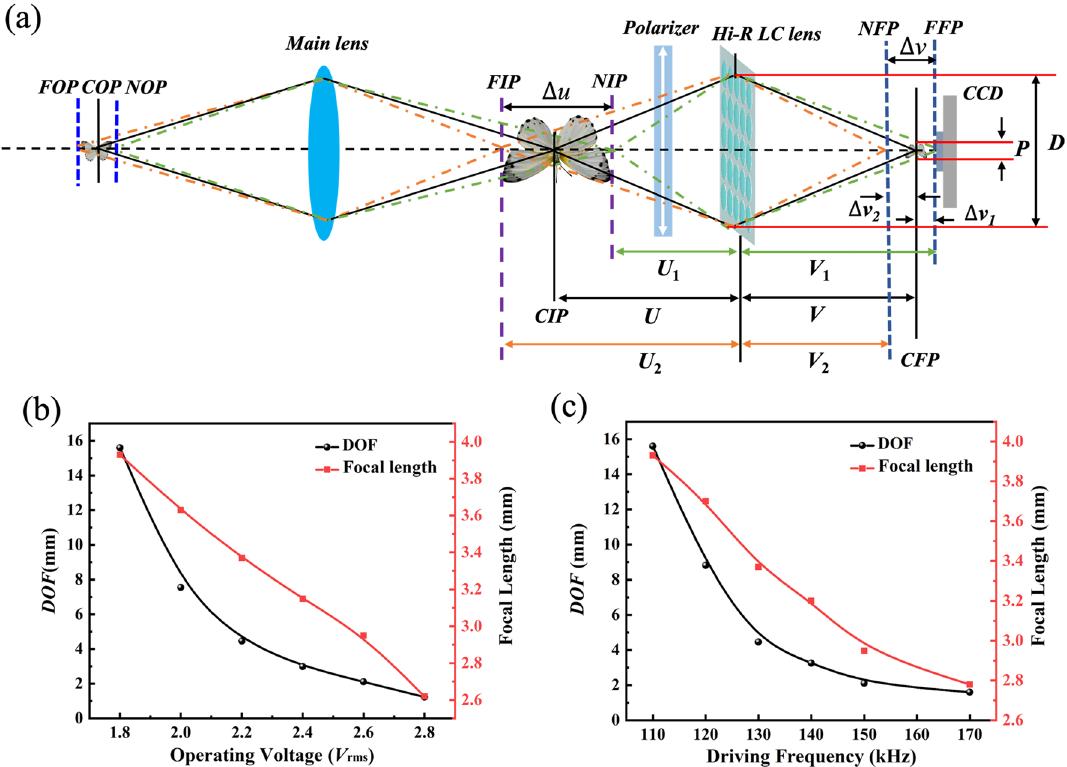
Figure 5. ( a ) The schematic illustration of the LFI system based on Hi-R LC MLAs; ( b ) the evolution of DOF and focal length with different operating voltage under the driving frequency of 130 kHz; and ( c ) the evolution of DOF and focal length with different driving frequency under the working voltage of 2.2 V rms